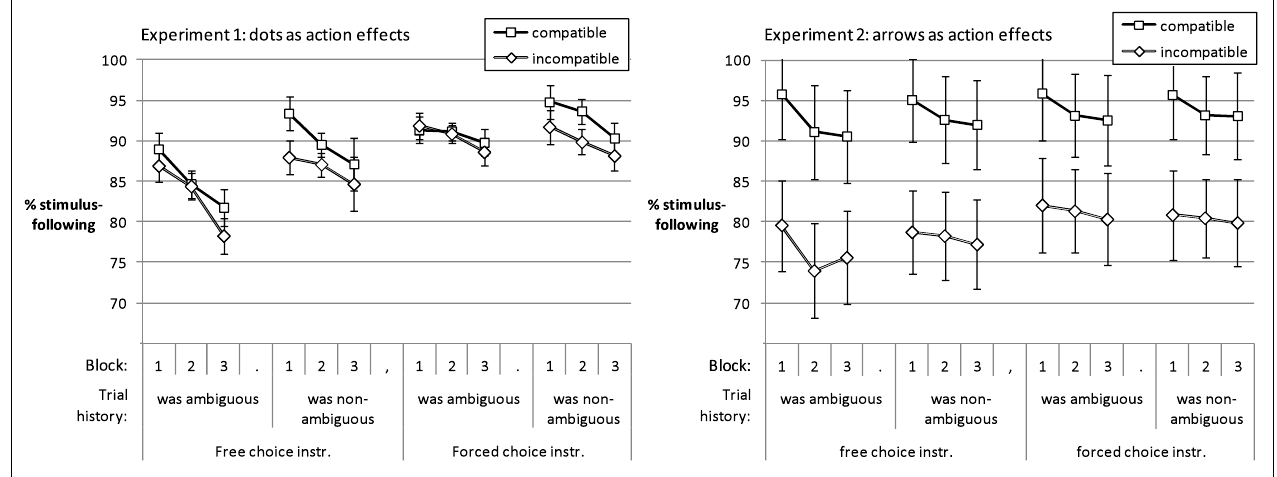
FIGURE 6 |Time course of proportion of trials with non-ambiguous stimuli in which participants followed the stimulus in their response choice.